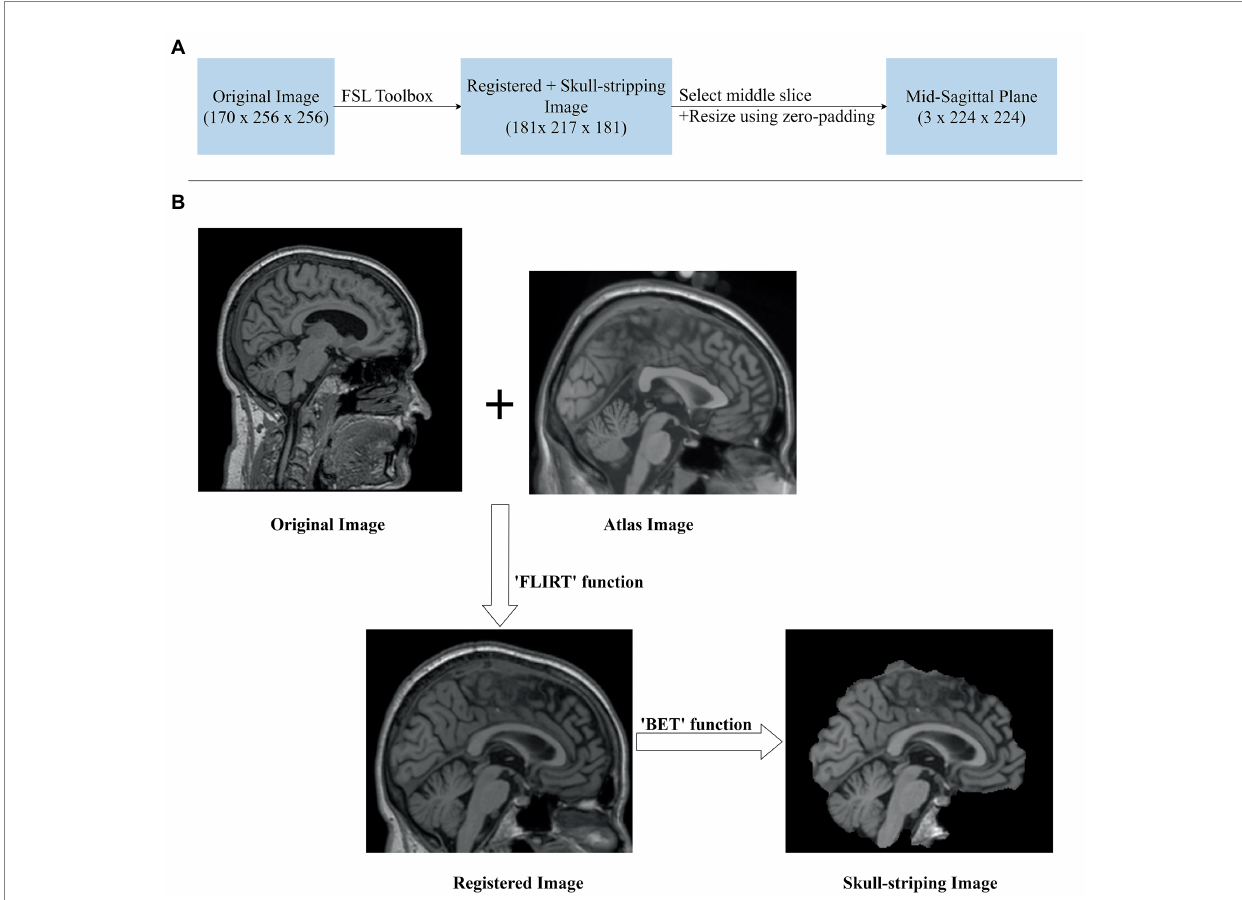
FIGURE 3 sMRI Image preprocessing. (A) Image preprocessing pipeline for extracting mid-sagittal plane and fit to the model. (B) Sagittal plane view of the image in original, registration, and skull-stripping